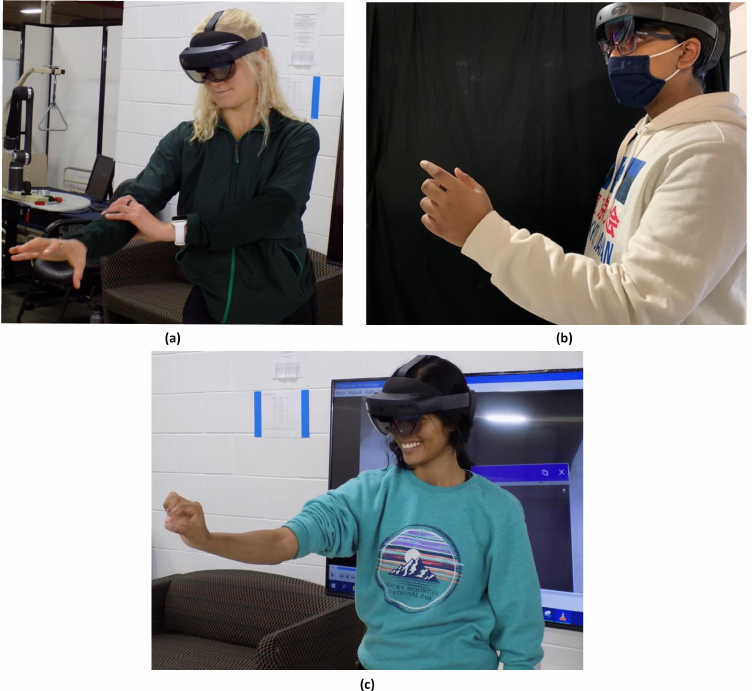
Figure 7. User testing the proposed MR-based video game on the HoloLens 2, ( a ) the user is knocking down structures in a game level ( b ) the user destroying all the spheres in a game level ( c ) completing a game level by picking an apple from a tree.